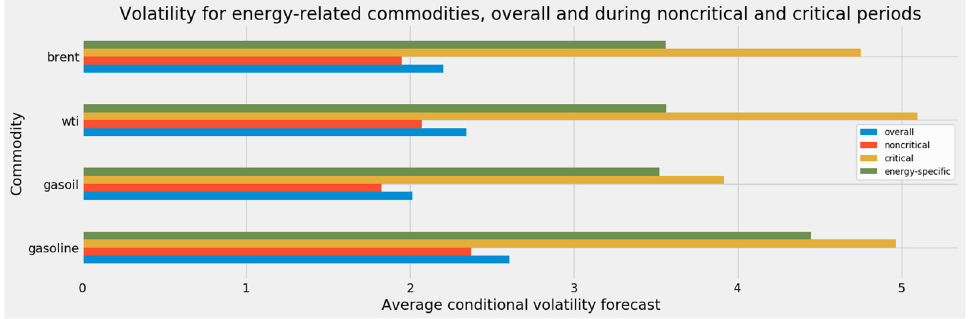
Figure 45. Volatility for energy-related commodities, overall and during noncritical and critical periods.